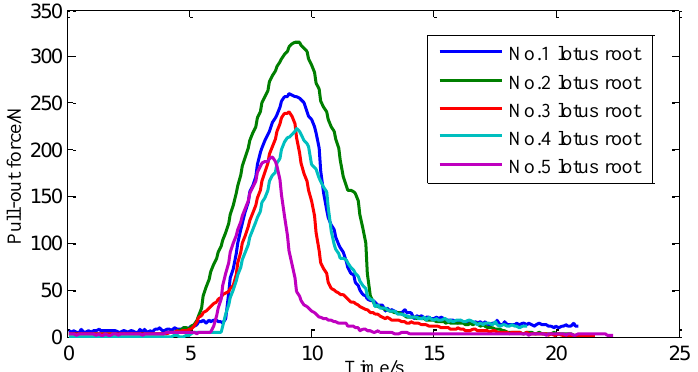
Figure 10. Force-time curves of five testing lotus roots with burial depth of 20 cm and pull-out speed of 6.9 mm/s.